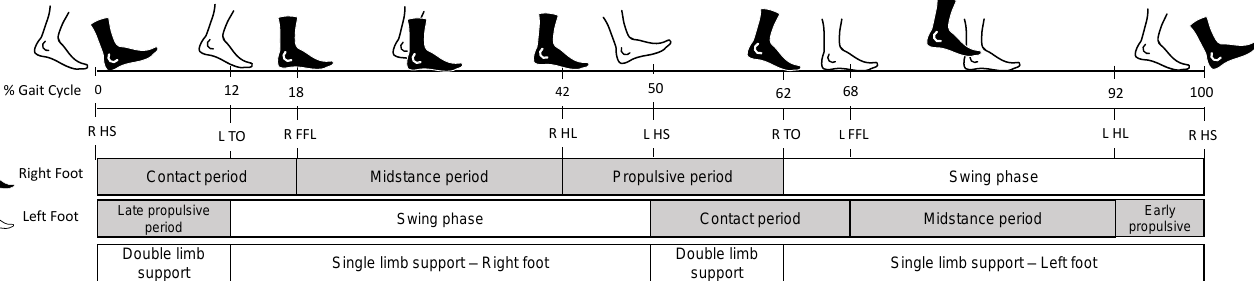
Figure 1. Human Gait Cycle (GC). The first line under the foot sketches represents the duration in percentage of the GC. Below the different gait events: Heel Strike (HL), Toe-Off (TO), Full Forefoot Load (FFL), Heel Lift (HL). Below are the segmented phases for the right and left feet. The last part indicates the relation between the left and right feet. The gait phase’s duration is approximate and varies between authors; these percentages are accepted in the